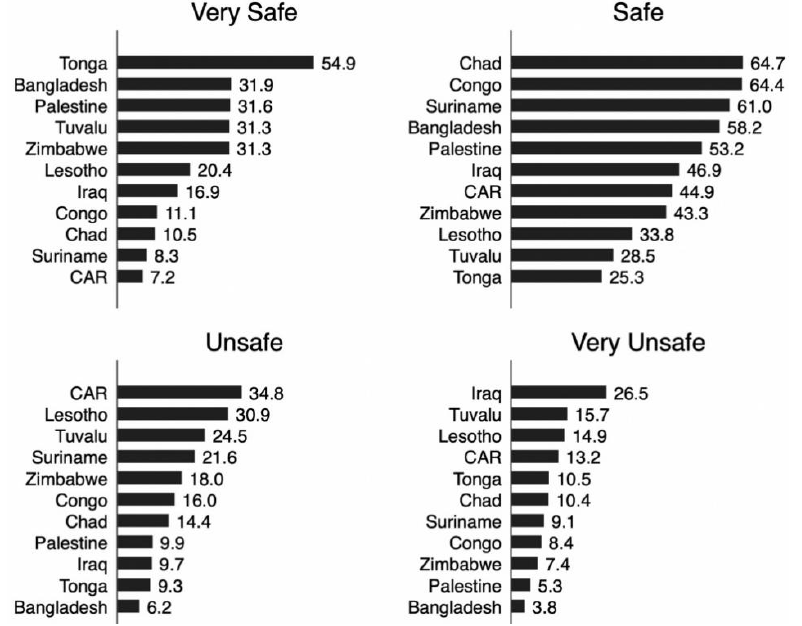
Figure 3. Percentage of reporting home safety by country.